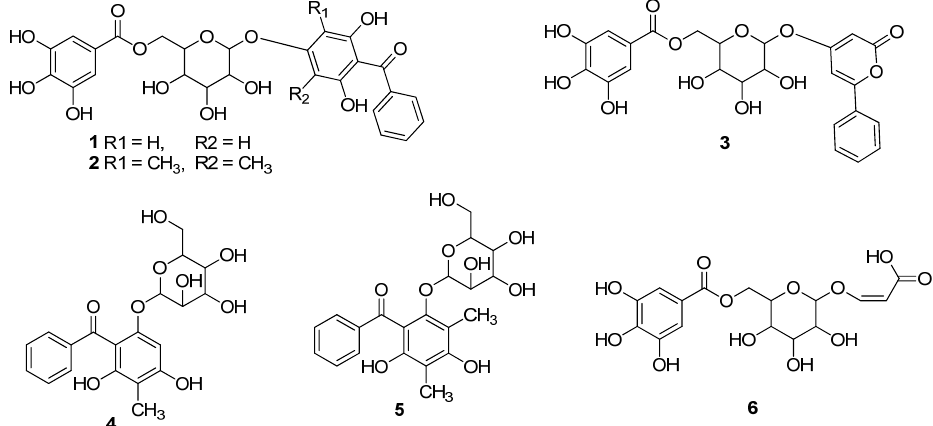
Figure 1. isolate from the leaves extract of the P. guajava L. Figure 1. Isolate from the leaves extract of the P. guajava